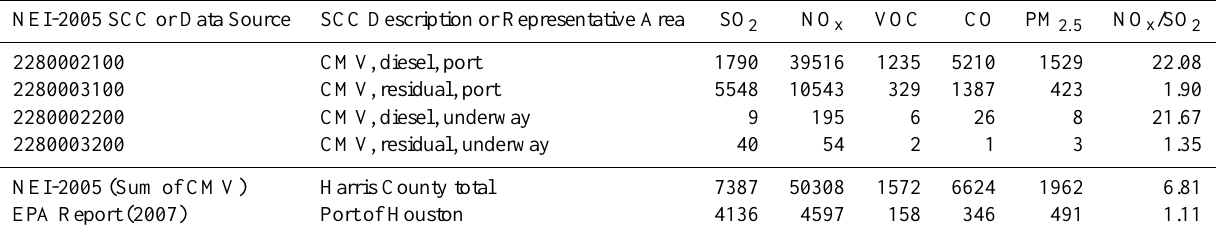
Table 7. Annually averaged port emissions (tonnesyr − 1 ) for SO 2 , NO x , VOC, CO, and PM 2 . 5 for Harris County from the NEI-2005 inventory, and for the Port of Houston from US EPA (2007). The emission mass ratios of NO x to SO 2 are also given. NEI-2005 SCC or Data